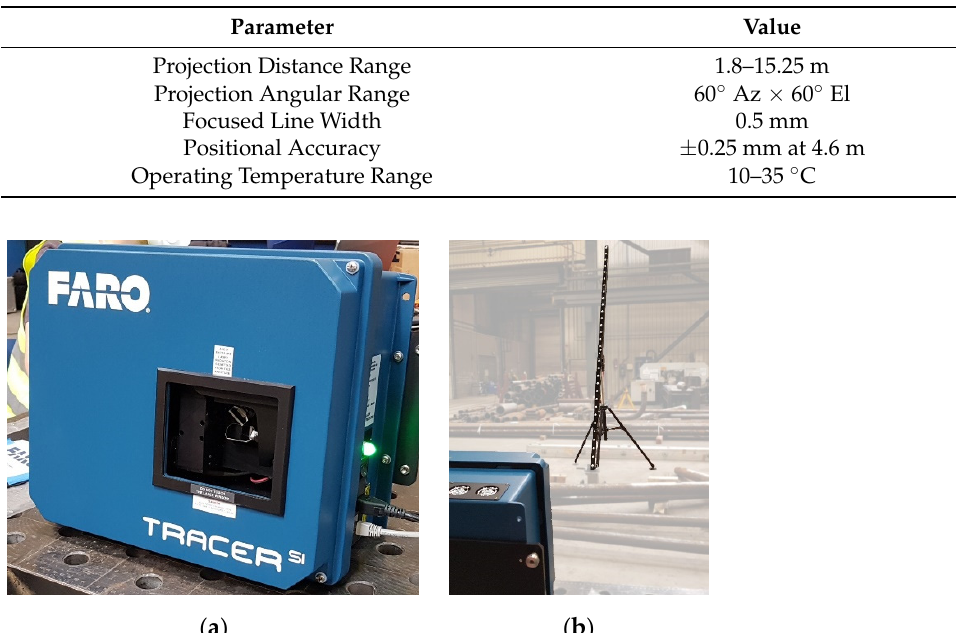
Table 1. Technical specification of the tested device [13].